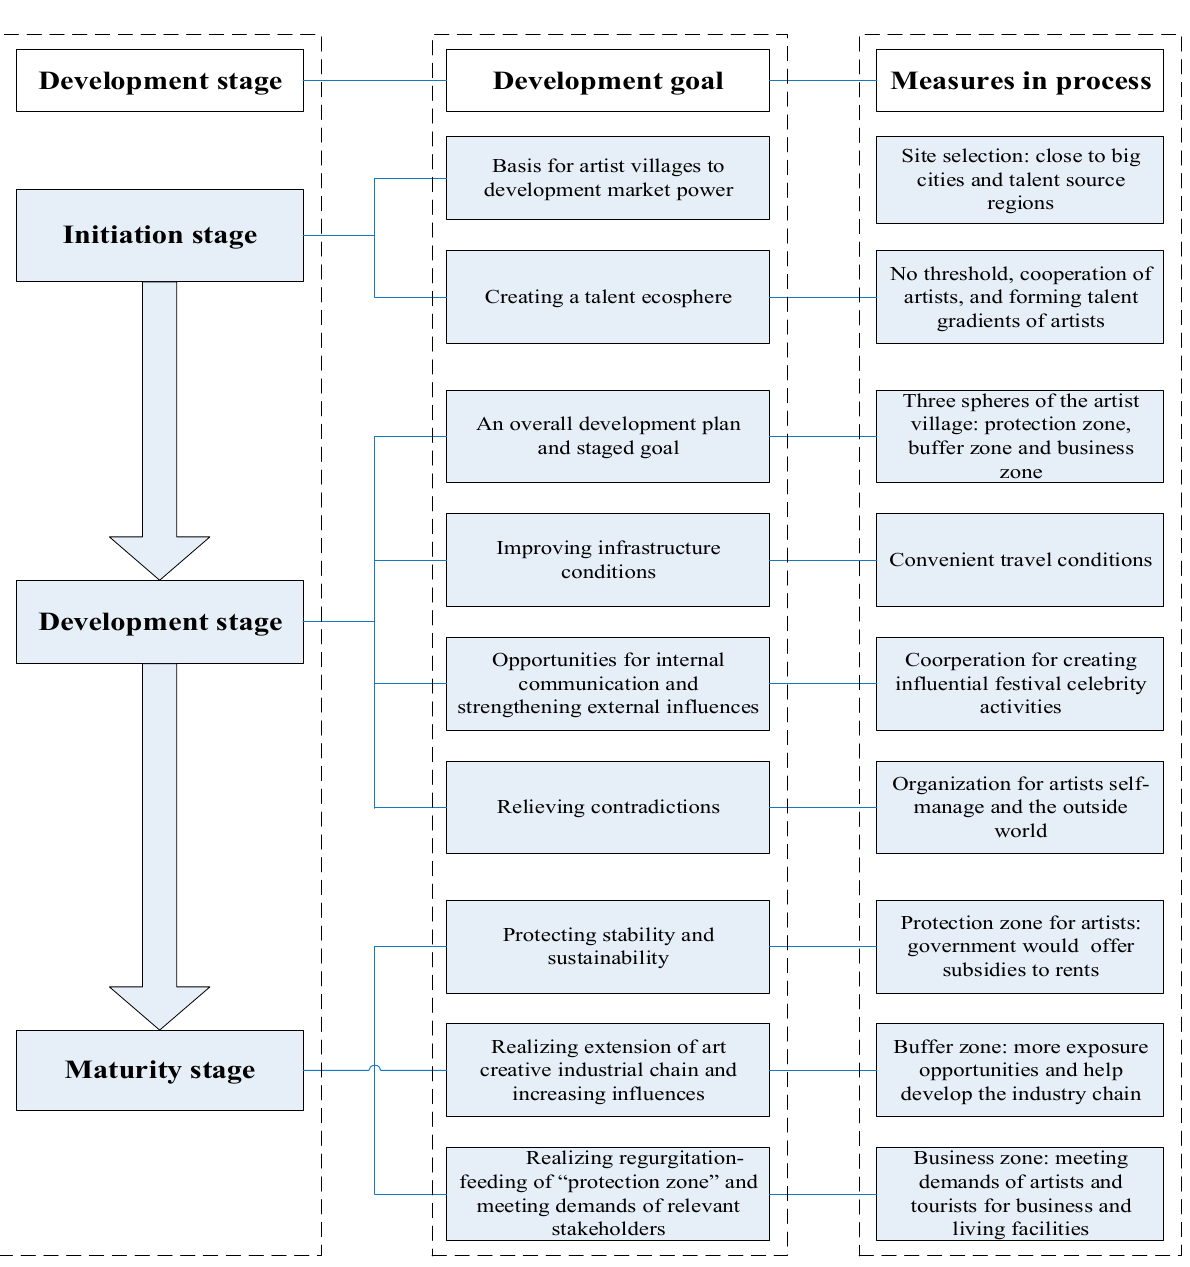
Figure 6. Development model of Artist Villages in China.